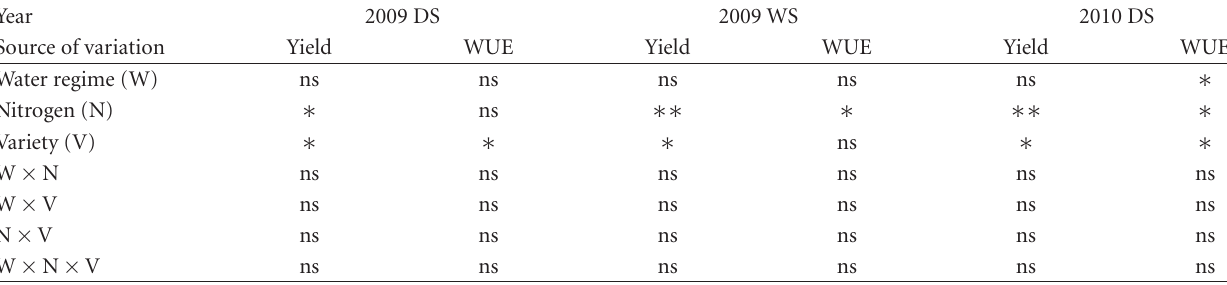
Table 2: Analysis of variance for grain yield and water use e ffi ciency (WUE) in the three consecutive seasons at IRRI farm,